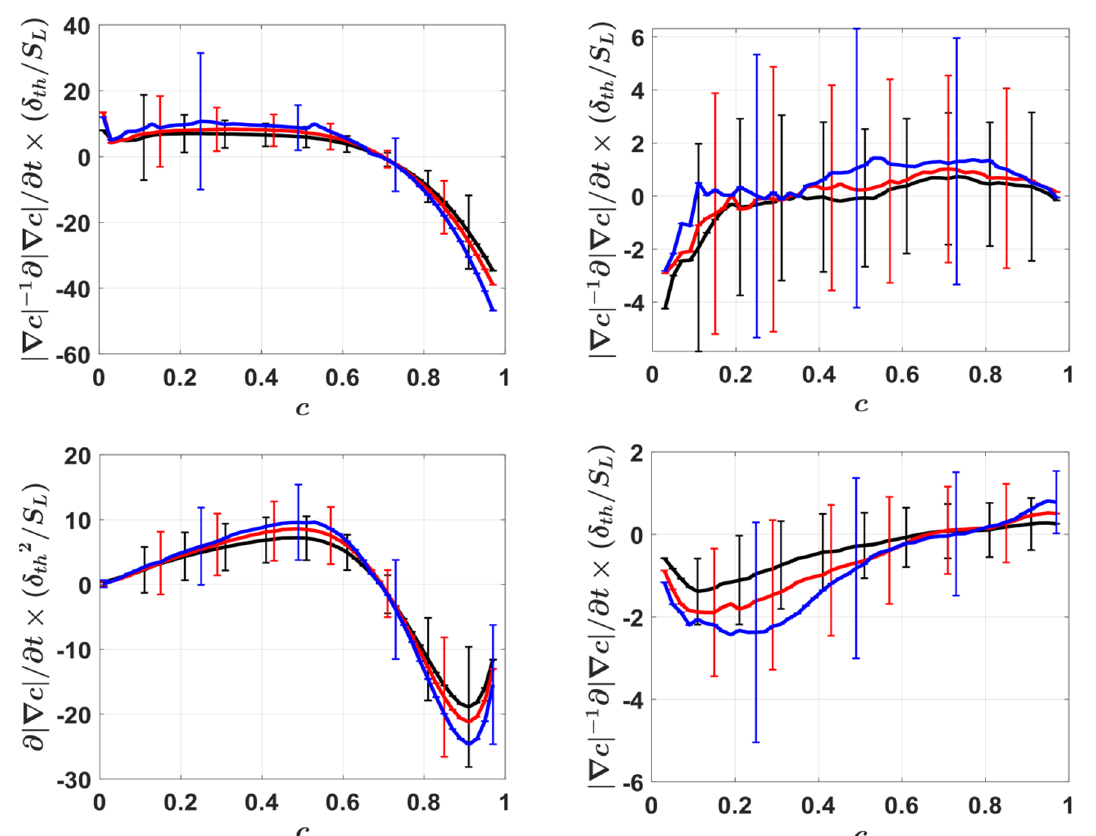
Figure 14. Profiles of the normalised mean values and standard deviations of ( |∇ c | − 1 ∂ |∇ c | / ∂ t × δ th / S L ) (top row) and ∂ |∇ c | / ∂ t × δ 2 / S L (bottom row) conditioned upon c for u (cid:48) / S L = 4.0 (black) 6.0 (red) and 8.0 (blue) for statistically planar turbulent premixed flames (first column) and homogeneous MILD combustion cases (second column). Note the difference in scales between the premixed flame and MILD combustion cases. The standard deviations of the MILD combustion cases are scaled by a factor of 0.1.